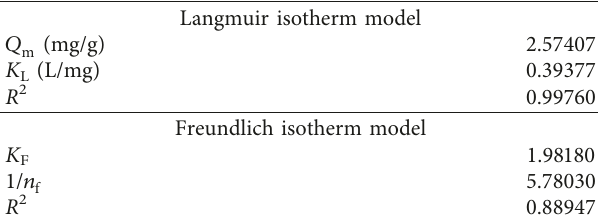
Figure 9: Graph of (a) Langmuir isotherm model and (b) Freundlich isotherm model. Table 3: Adsorption isotherm